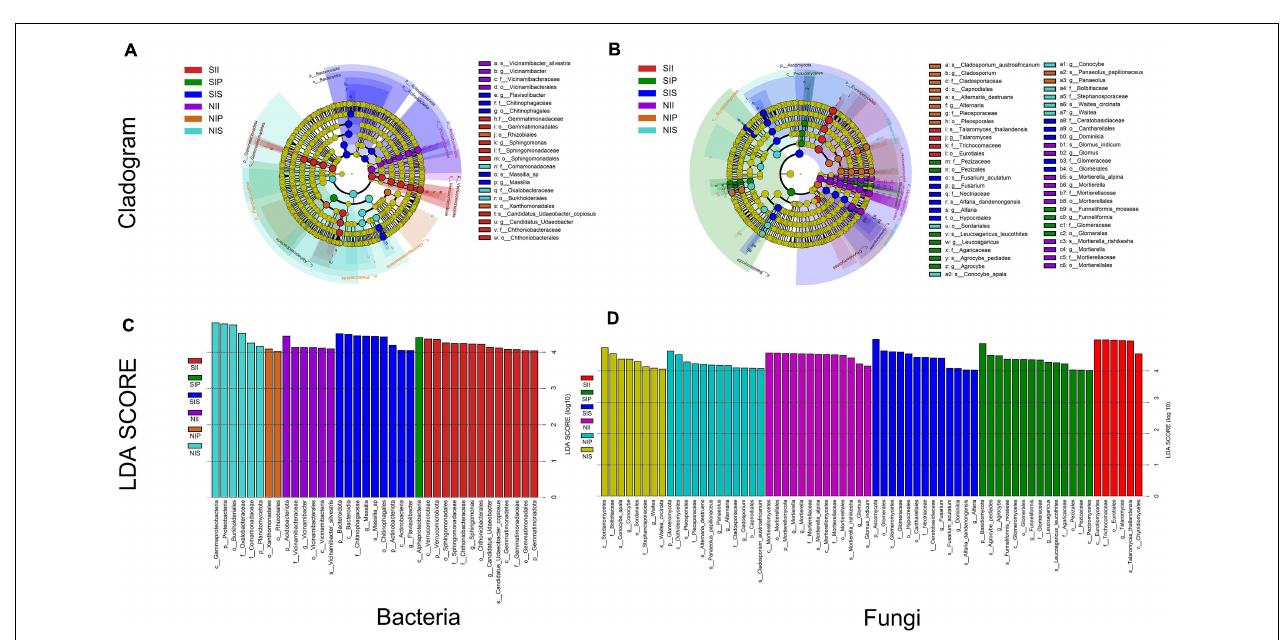
FIGURE 6 | Redundancy analysis of the peanut rhizosphere (IP), sorghum rhizosphere (IS), and interspecific interaction zone (II) microbial communities at the phylum level under different soil conditions (S, 0.25% salt-treated soil condition; N, normal soil condition). TN, total nitrogen; NH 4 + -N, ammonium nitrogen; AP, available phosphorus; AK, available potassium. (A) Redundancy analysis (RDA) of bacterial community. (B) Redundancy analysis (RDA) of fungal community.